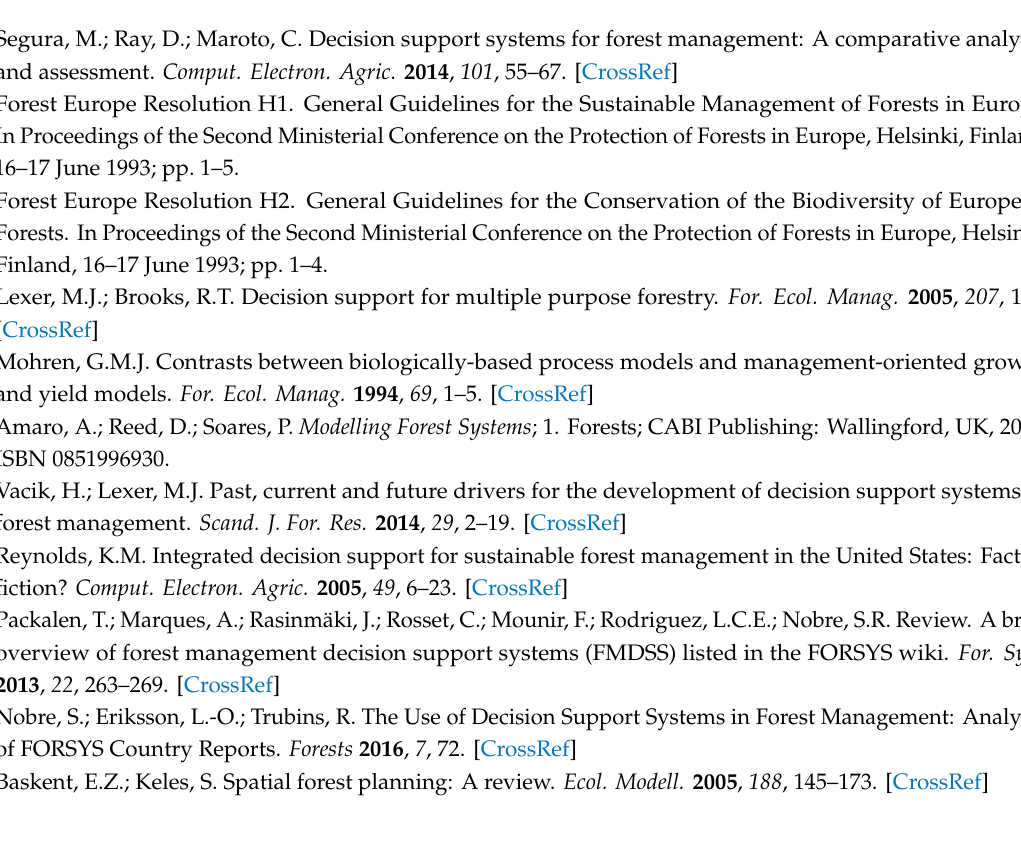
Table S1: Functionalities of the FORSYS wiki software (adapt Packalen et al., 2013) and ForestDSS Wiki (last access on 27 July 2019); Table S2: Main information that must be contained in the report that the forest owner must provide to the competent authority according to the regional forest law and the related items that the S-DSS can provide him / her